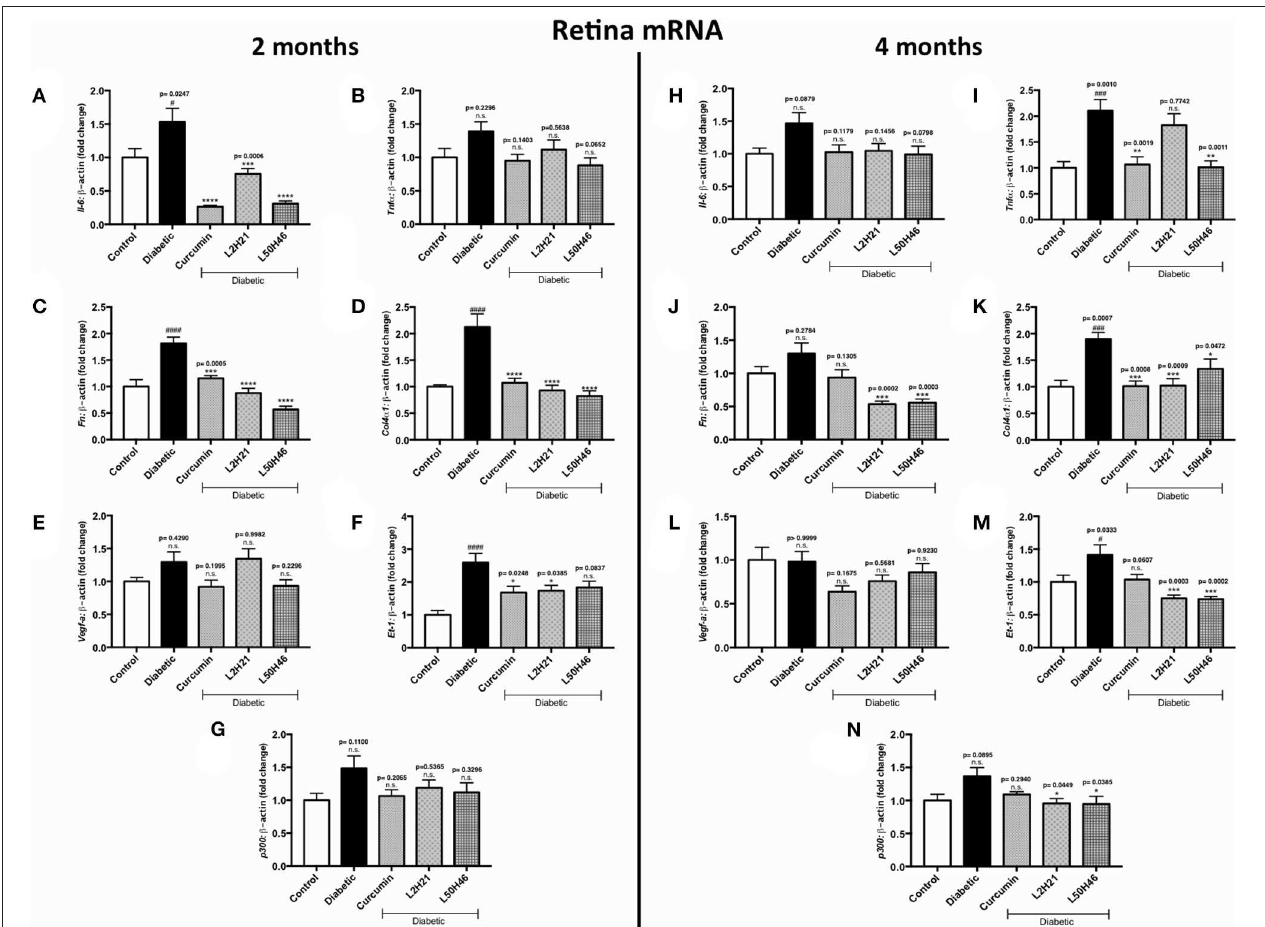
FIGURE 4 | Effects of curcumin and its analogs on retinal transcripts at 2- and 4-months following induction of diabetes. Left panel: RT-qPCR analyses showing the upregulation of (A) Il-6 , (B) Tnf- α , (C) Fn , (D) Col4 α 1 , (E) Vegf-a , (F) Et-1 , and (G) p300 mRNAs in the retinal tissues of diabetic mice at 2 months. Administration of curcumin or its analogs produced differential RNA expressions in the retinal tissues of diabetic mice. Right panel: RT-qPCR analyses demonstrating relative increases of (H) Il-6 , (I) Tnf- α , (J) Fn , (K) Col4 α 1 , (L) Vegf-a , (M) Et-1 , and (N) p300 mRNAs in the retinal tissues of diabetic mice at 4 months. Treatment with curcumin or its analogs produced differential transcript expressions [data expressed as a ratio to β -actin (mean ± SEM); normalized to non-diabetic control; # significance between Control vs. Diabetic; *significance between Diabetic vs. Treatment group; * , # P < 0.05, ** , ## P < 0.01, *** , ### P < 0.001, and **** , #### P < 0.0001; n =